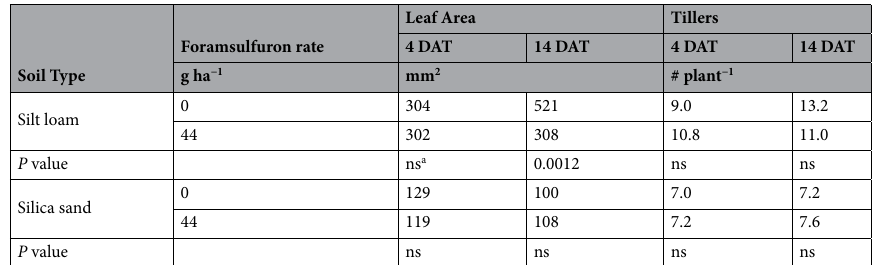
Table 3. Leaf area and tiller counts for goosegrass [ Eleusine indica (L) Gaertn] plants treated with foramsulfuron (44 g ha −1 ) in vapor pressure deficit experiments at the West Tennessee Ag Research and Education Center (Jackson, TN) during 2019. Data collected from plants maintained at a vapor pressure deficit of > 3.0 kPa and air temperature of 38 °C. a ns = not significant via Tukey’s Honestly Significant Difference Test at α =